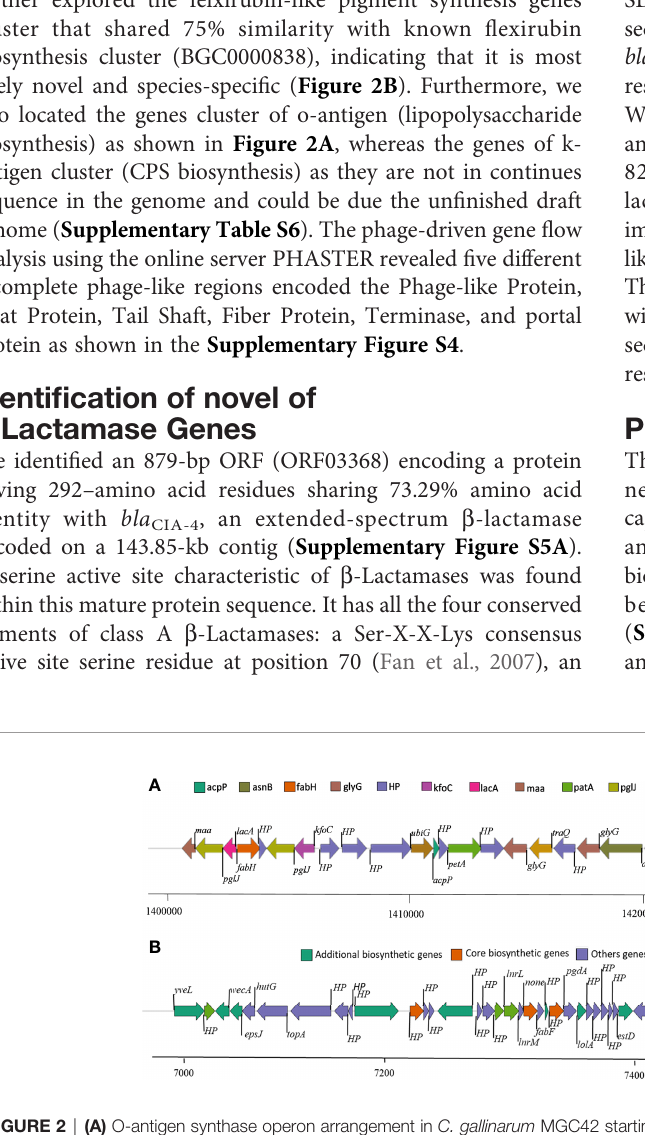
FIGURE 2 | (A) O-antigen synthase operon arrangement in C. gallinarum MGC42 starting from 1411059 to 1420661 bp. (B) Polyketide synthesis operon arrangement in C. gallinarum MGC42 at ORF 700929 to 765695. Genes of the same functional classi fi cation are shown in the same